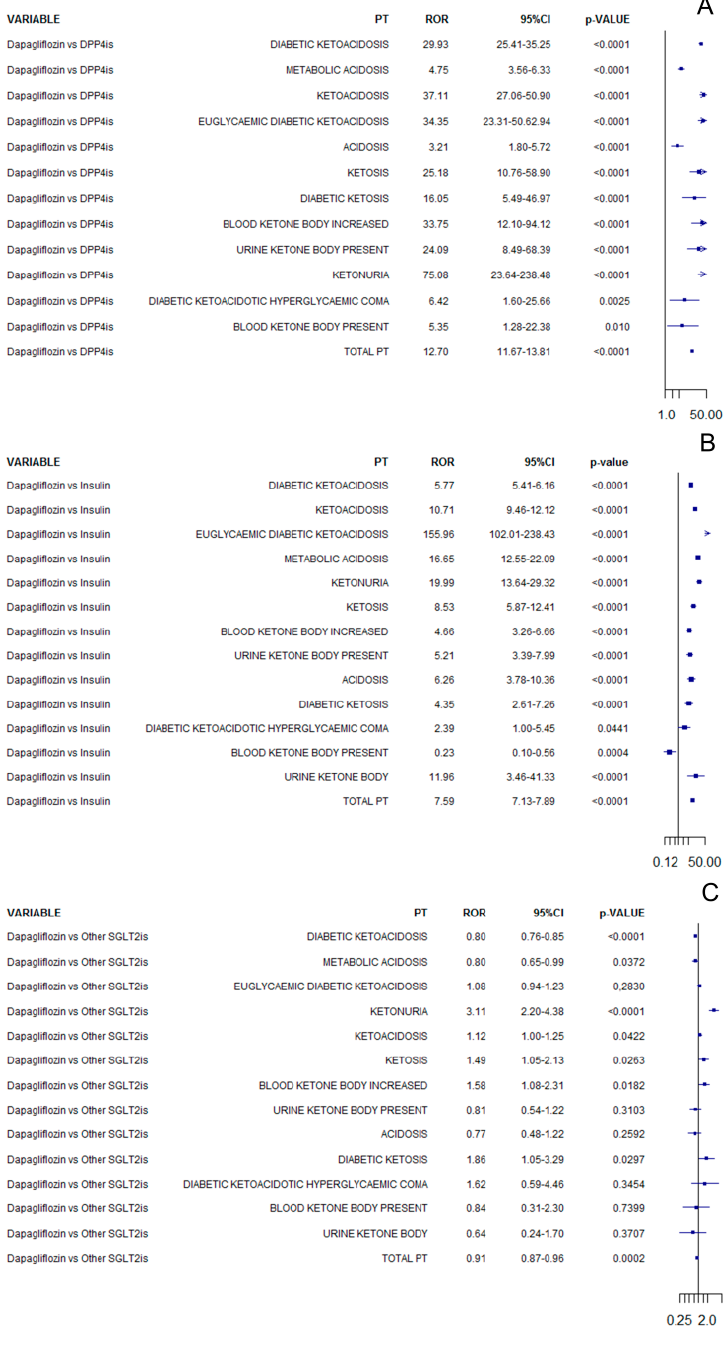
Figure 1. ROR of ketoacidosis adverse events for dapagliflozin compared to DPP-4is ( A ), insulin ( B ), or other SGLT2 inhibitors ( C ) in all cases of diabetes mellitus. In the direct comparison between SGLT2 inhibitors, no difference was observed when dapagliflozin was compared to canagliflozin (ROR 1.04, 95%CI 0.99–1.10; Figure S3)